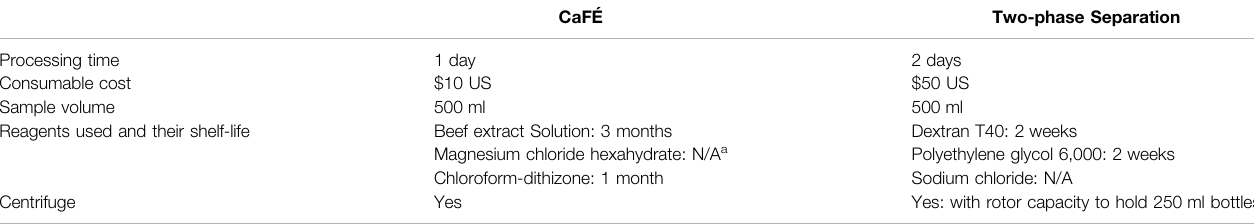
TABLE 4 | Comparison of features between the two-phase separation method and concentration and fi ltration elution (CaFÉ) method.